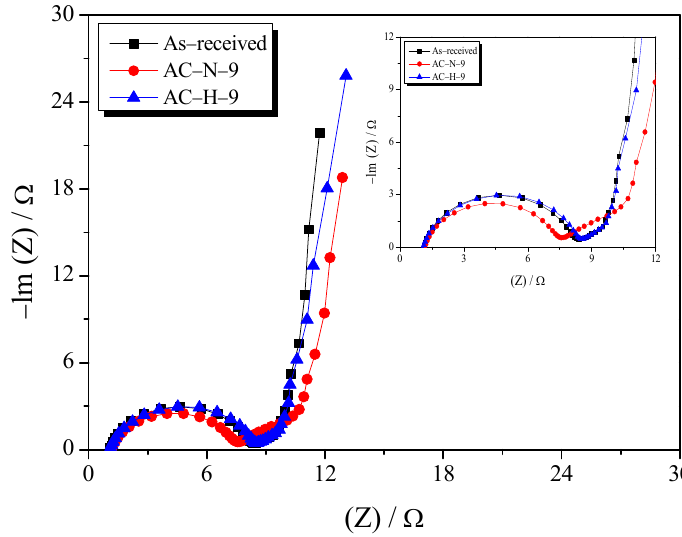
Figure 10. Nyquist plot of AC heat-treated under different conditions. Figure 10. Nyquist plot of AC heat ‐ treated under different conditions. The first element of the Nyquist plot is the bulk-solution electrolyte resistance ( R S ), which can be easily identified using the x-intercept at high frequencies. The R S depends on the type or concentration of the electrolyte used for the EDLC. Because the same electrolyte (1 M TEABF 4 /PC) was used in this study, similar R S values were obtained (1.06–1.30 Ω ). The second element is the R CT , which is represented by a semicircle in the intermediate frequency range. R CT is a composite resistance that accounts for various factors, such as the electrical conductivity of the electrode active material, interfacial resistance occurring at the interface between the active material and the electrolyte, and contact resistance between the electrode and current collector. The R CT values of AC-N-9 and AC-H-9 were similar to those of the as-received sample (6.42–7.41 Ω ). AC-N-9 and AC-H-9 were presumed to have a positive effect on R CT through the reduced interfacial resistance and increased electrical conductivity, which were attributed to the removal of abundant OFGs, as well as a negative effect on the formation of the electric double layer owing to the increase in pore diameter during the OFG removal process. Similar R CT values were observed for all samples, including the as-received sample, because of these complex factors. However, AC-N-9 had the smallest R CT value because of the development of new micropores, as shown in Figure